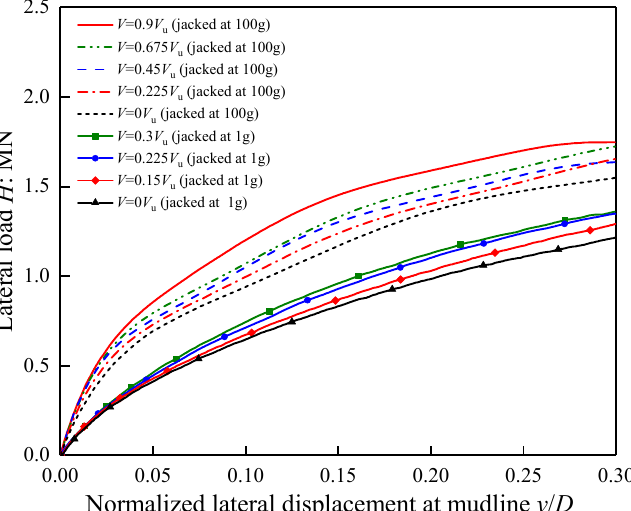
Figure 13. Influence of vertical loading on the lateral displacement of pile (reproduced from Li et al. (2022) [128]).